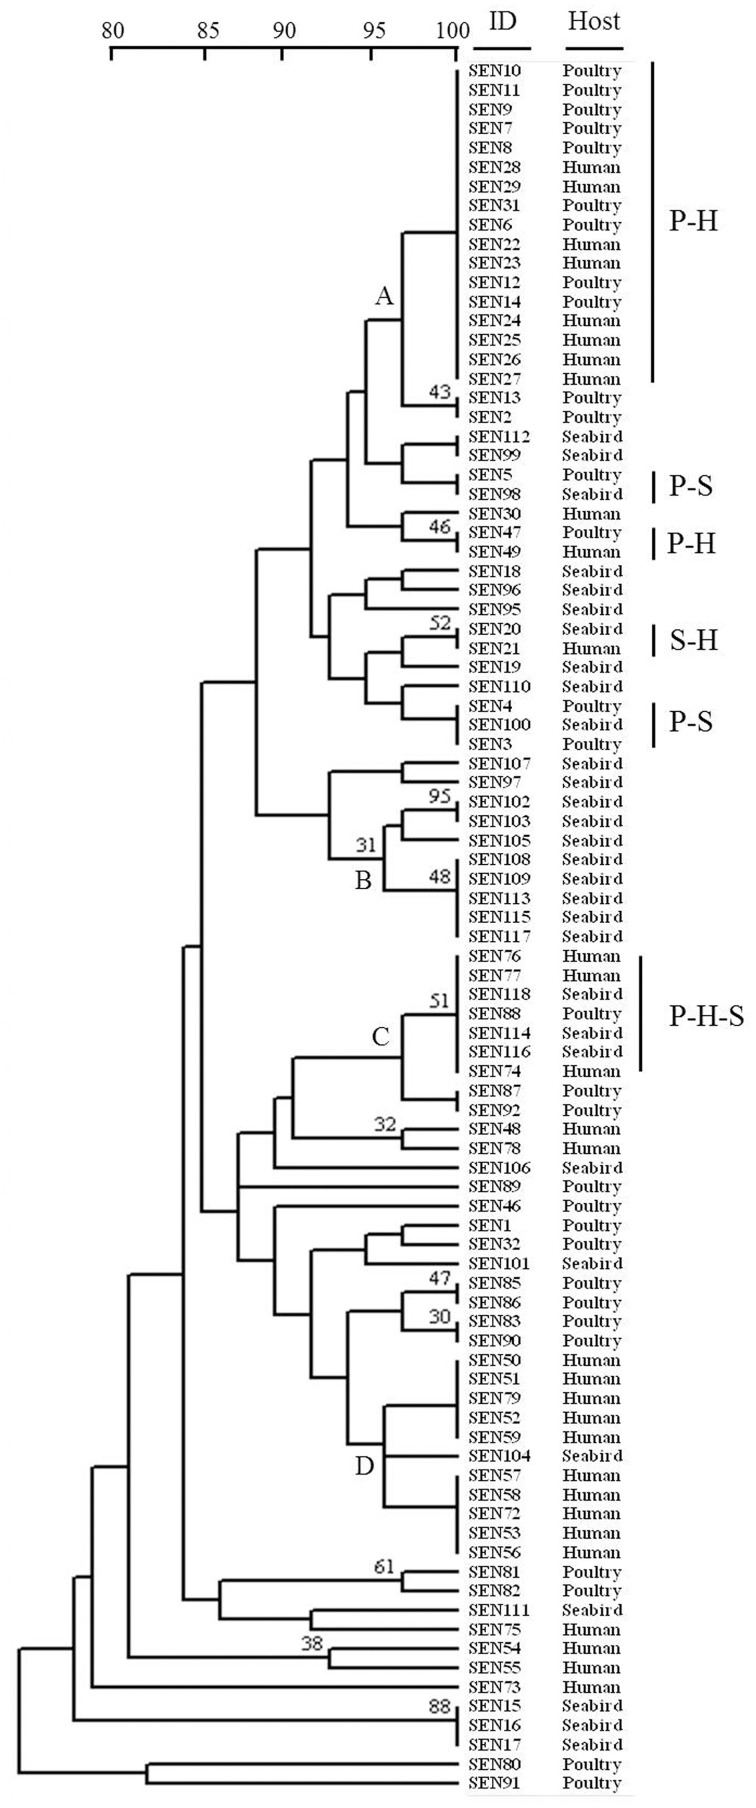
Dendogram showing genetic similarities (%) between Salmonella enterica serovar Enteritidis strains resulting from combined PFGE and PCR data. The ID and host are shown for each isolate. Clusters with at least five isolates sharing more than 95% similarity are indicated with letters A, B, C, and D. Mixed clusters are indicated with letters according to hosts (P, poultry; H, human; S, seabird). The tree was constructed using the UPGMA method with the software TREECON.